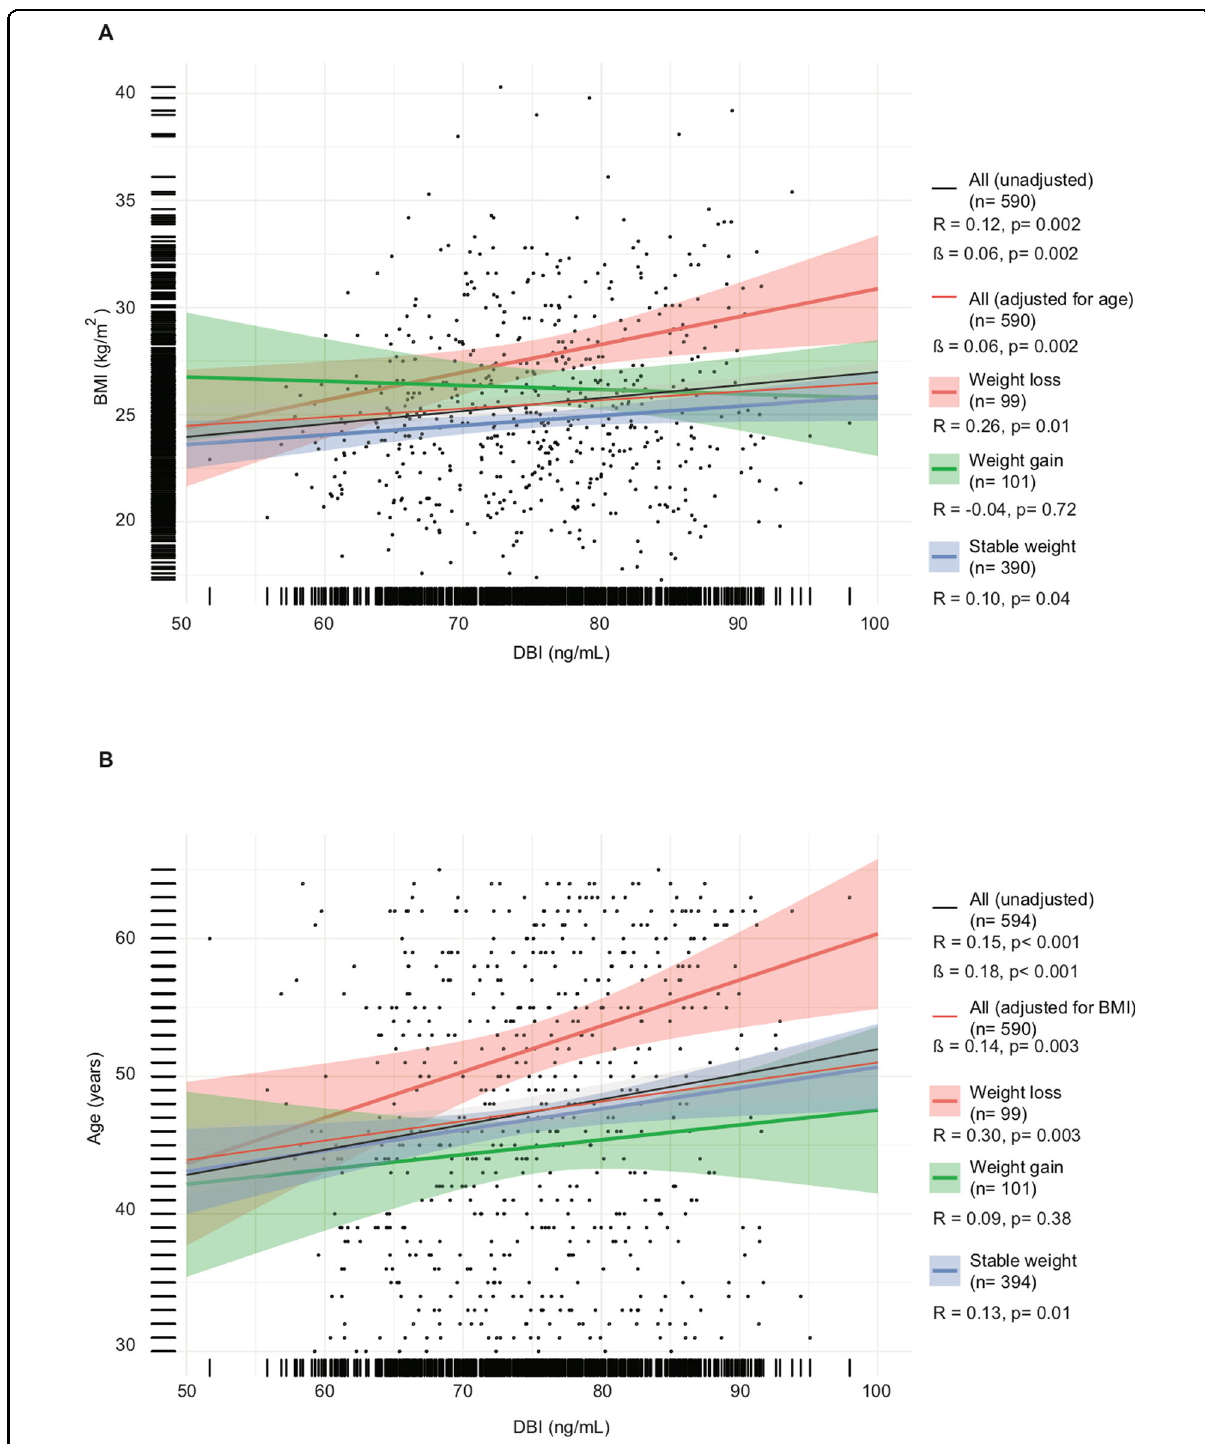
Fig. 3 ACBP/DBI correlates independently with BMI and age except in patients with subsequent weight gain. Scatter plot with regression line between ACBP/DBI (ng/mL) and body mass index (kg/m 2 ) ( A ) or age ( B ) in patients who lose weight ( ≥ 5%), gain weight ( ≥ 7%), or remain stable (variations <2%) in the DESIR cohort. Pearson ’ s correlation coef fi cient (R) and their p value, number of samples available ( n ) and estimates (ß) from a linear model before and after adjustment are shown in the legend of each